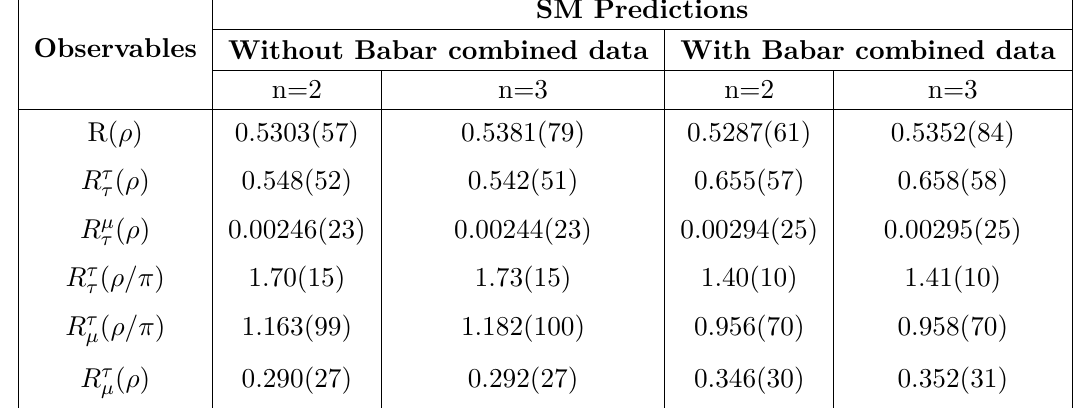
Table 6. SM predictions for the observables defined in (2.10), R τ allowed kinematic ( 0 ≤ q 2 ≤ 20 . 29 ) regions corresponding to n = 2 and n = 3 parametrizations